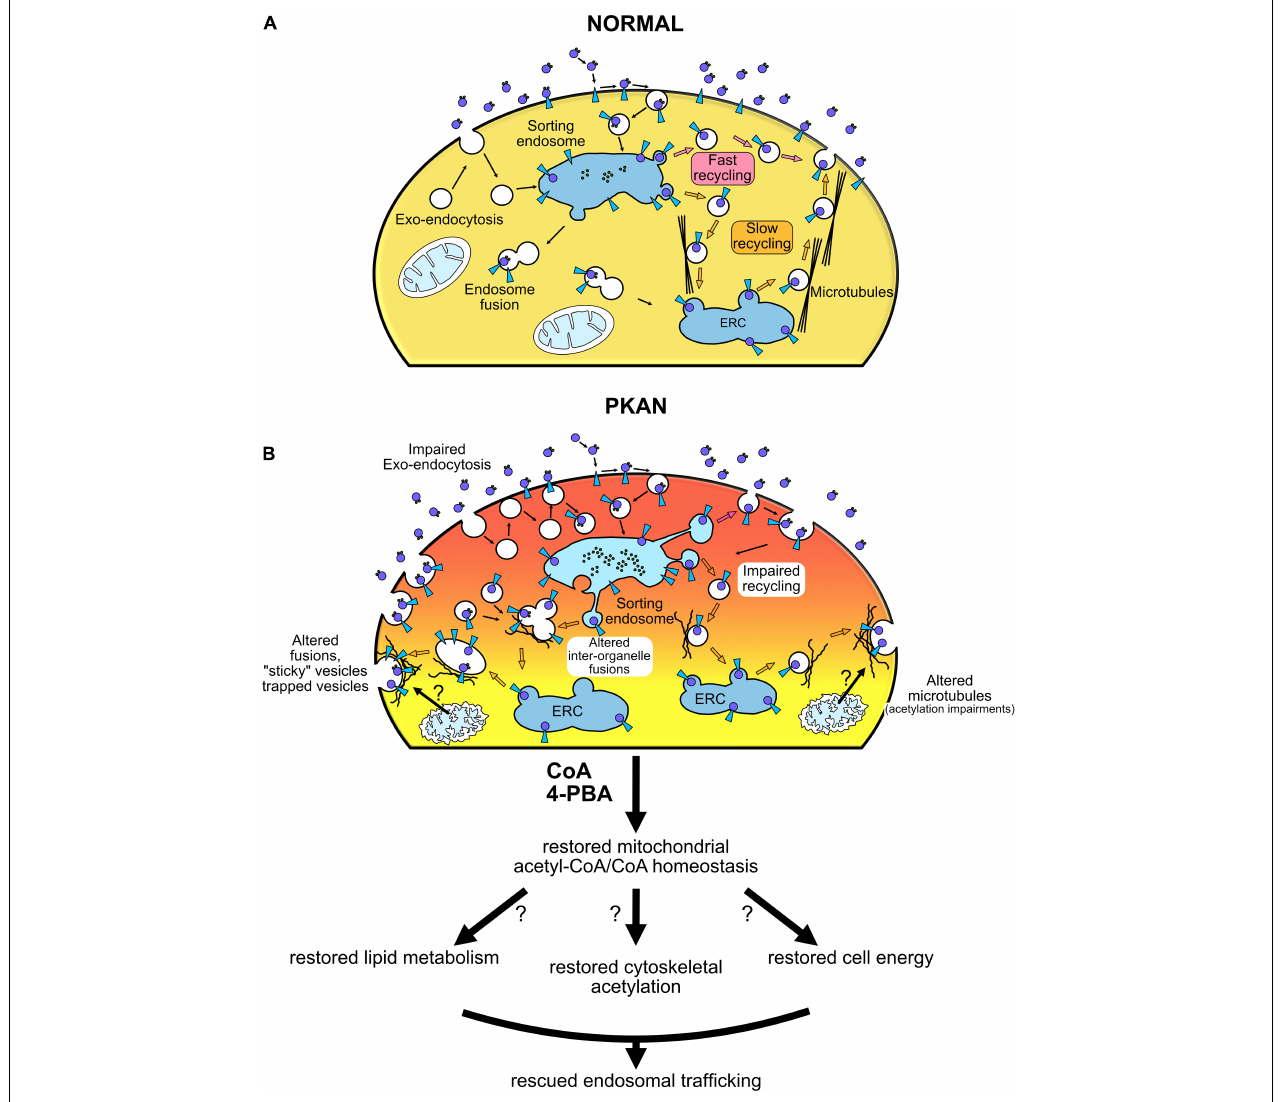
FIGURE 5 | Vesicular trafficking impairment in PKAN leads to gliosis and neurodegeneration. Schematic cartoon illustrating our hypothesis of endosomal trafficking impairment in PKAN. (A) Normal condition, (B) altered dynamics in PKAN astrocytes. CoA deficiency in PKAN astrocytes leads to an impediment to normal physiological intracellular trafficking of the endosomal compartment. The aberrant endosomal behavior could be related to distorted biophysical properties of endosomes, such as membranes’ different lipid composition that modifies membranes fusion dynamics, but also to an unbefitting cytoskeletal milieu. The altered lipid composition by itself might also cause problems in the interactions between vesicles and normal cytoskeletal proteins.